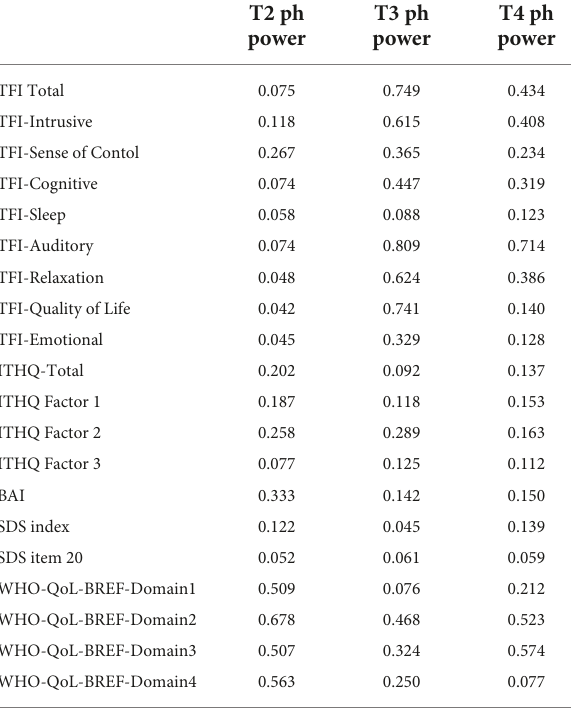
TABLE 7 Statistical power of our results based on a post hoc power analysis.